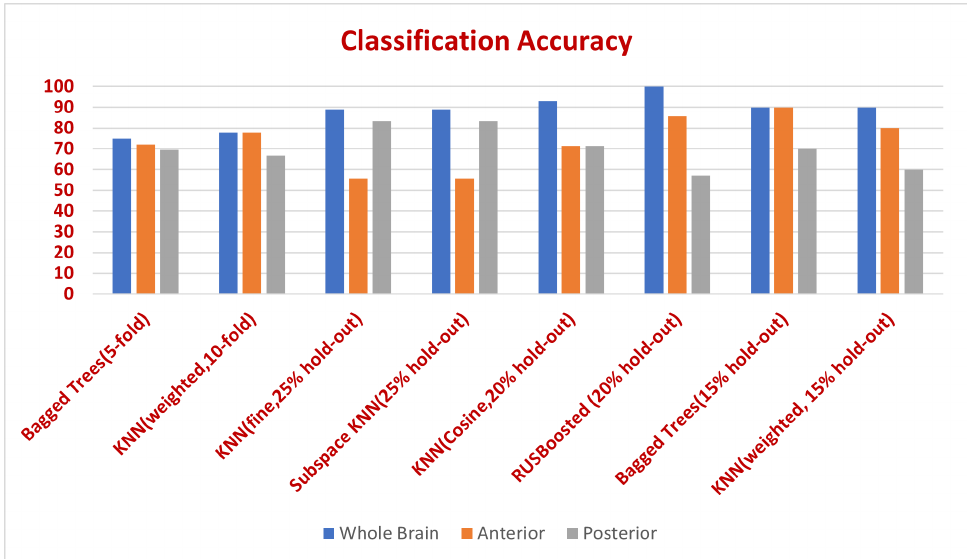
Figure 10. Classification accuracy in whole brain, anterior, and posterior compartments for different classifiers and validation